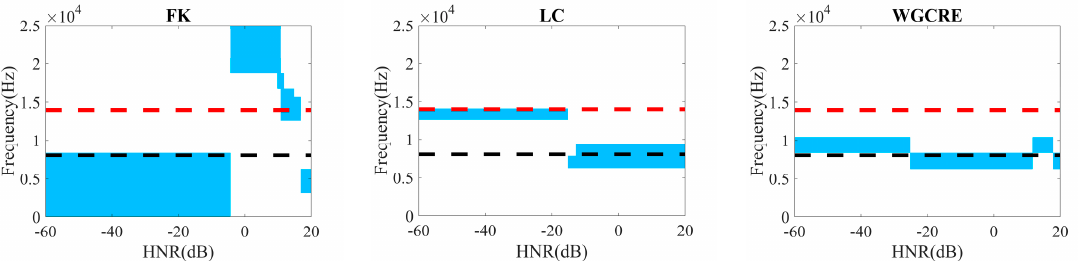
Figure 8. Selected optimal demodulation bands under smooth CS2 noise for different HNR.